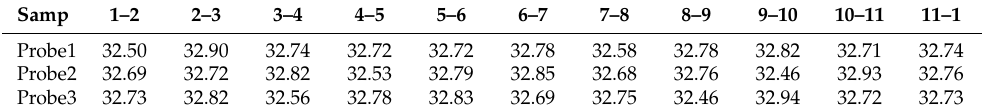
Table 1. Precise angle (°) between consecutive samples estimated from the three different probes. The minimum estimate accuracy is ± 0.07 °. The ideal would be 360°/𝑀 = 32.727 °